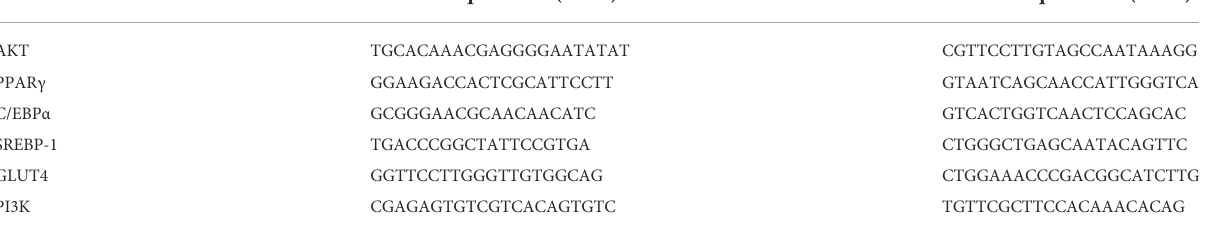
TABLE 1 qPCR primer